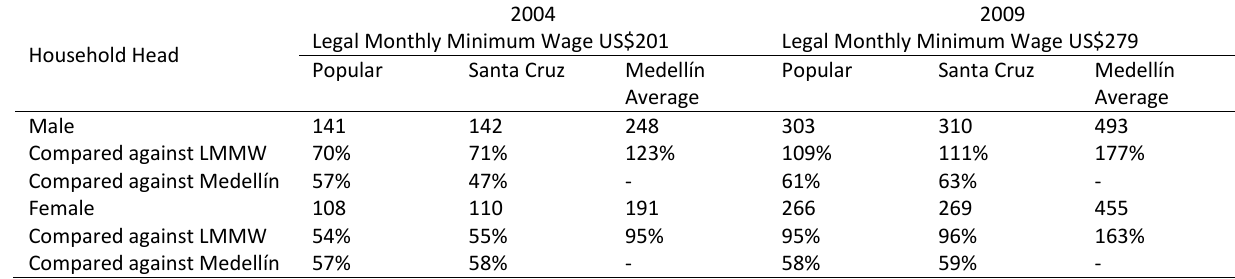
Compared against LMMW Source: Coupé and Cardona (2012), p.